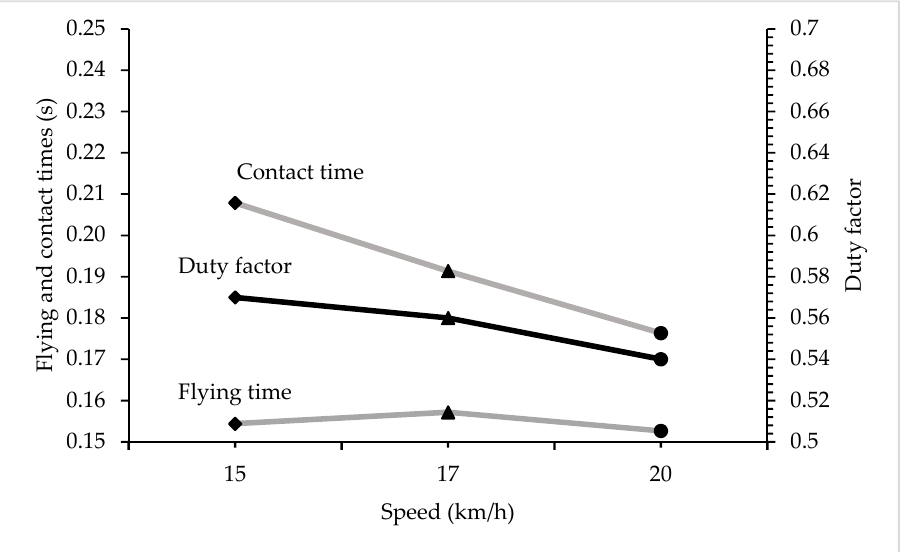
Table 4. Contribution of the biomechanical parameters to the performance at different speeds.